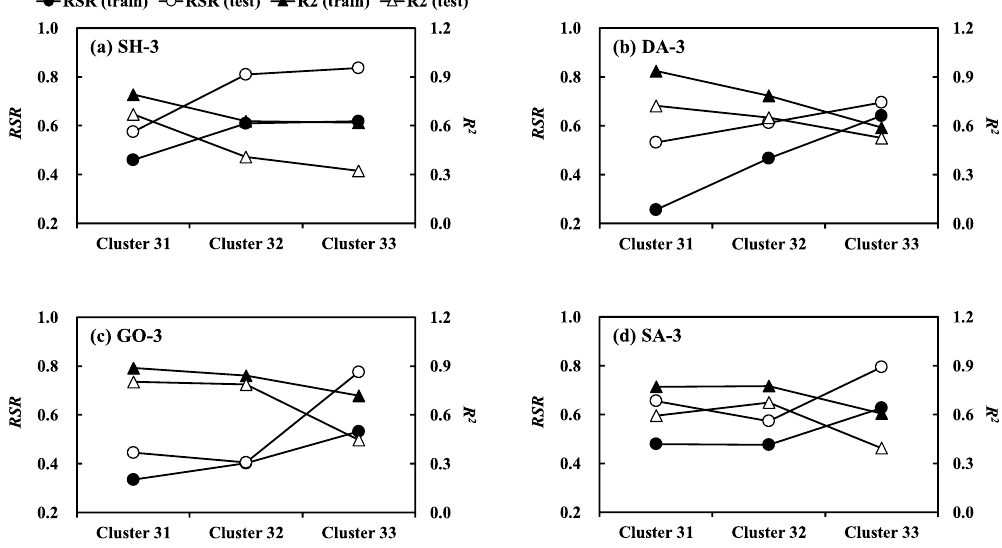
Figure 3. Prediction accuracy of 3-cluster ANN models in predicting Chl-a belonging to different